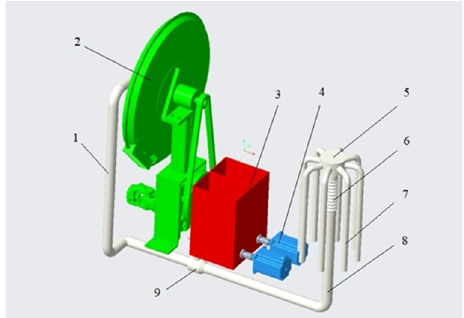
Figure 1. Air-blowing seed meter. (1. Air inlet pipe; 2. Fan component; 3. Mixed seed box; 4. Stepper motor; 5. Conical distributor; 6. Corrugated booster pipe; 7. Seed-feeding pipe; 8. Seed-feeding elbow; 9. Venturi tube).